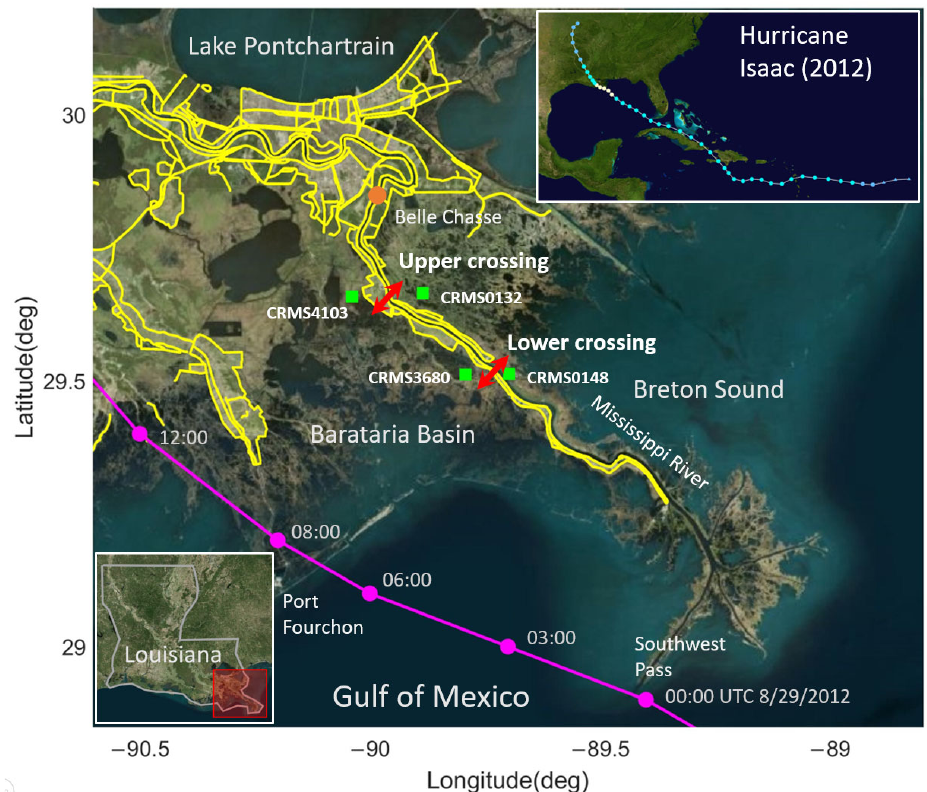
Figure 1. The lower MR river delta area. Yellow lines denote the MR&T levees. Two double headed red arrows denote the levee removal locations. Blue squares denote water level gauges. Orange circle denotes the discharge boundary location of the MR river in the model. Magenta line with dots denotes the track of Isaac (2012). The full track is shown in the top ‐ right subfigure (revised from https://en.wikipedia.org/wiki/Hurricane_Isaac_(2012)#/media/File:Isaac_2012_track.png, accessed on 25 October 2022).